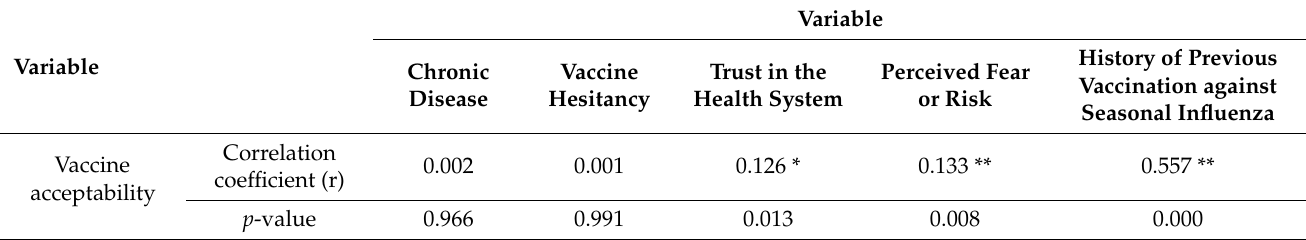
Table 3. Correlation results of vaccine acceptability and independent variables ( n =